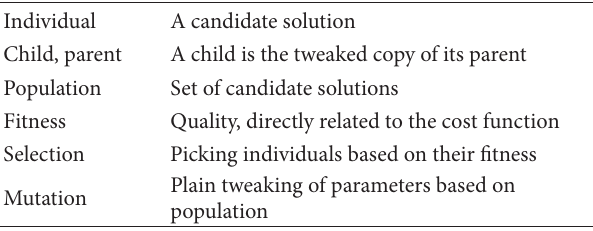
Table 3: Evolutionary computation nomenclature (from